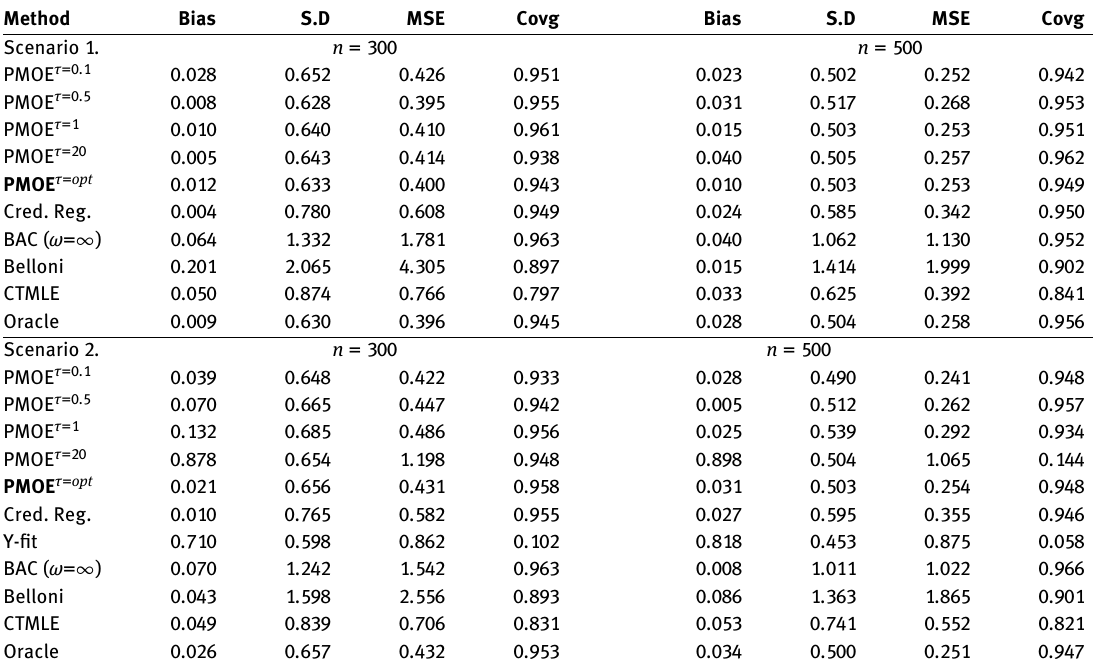
Table 1: Simulation results for scenarios 1 & 2. Bias, S.D. and MSE are for the treatment effect.